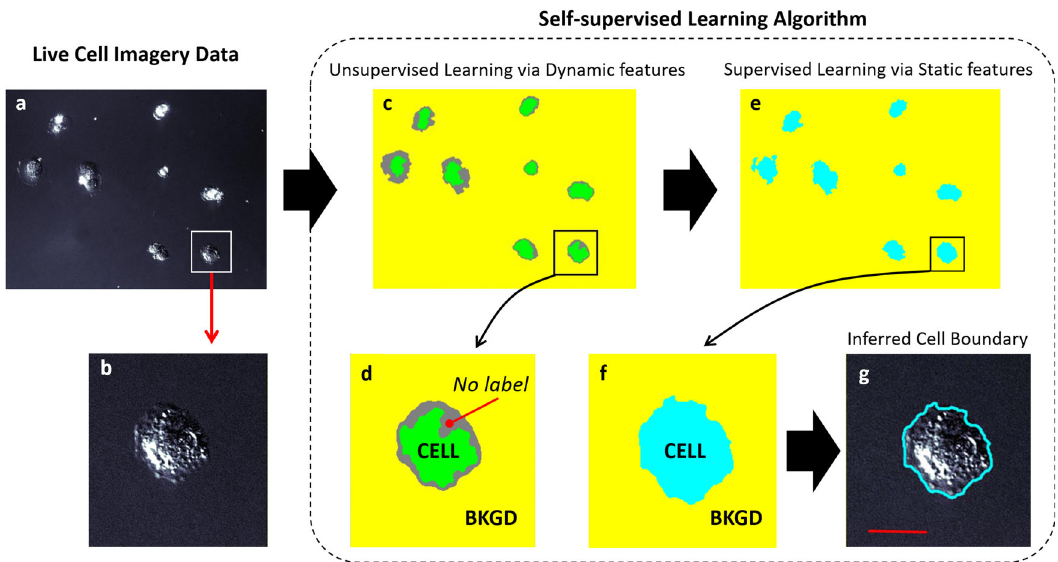
Fig. 2 Overview of the automated self-supervised learning algorithm. a The contrast enhanced DIC image of several and b a single highlighted MDA-MB- 231 cell illustrates the range of intensities inherent within the cells. (20X objective). c , d Unsupervised learning via FD: high threshold FD is used to select only those pixels exhibiting the highest displacement magnitudes and labels them as ‘ cell ’ (green pixels). Similarly, low threshold FD is used to identify pixels with a much wider range of displacement magnitudes than the high fl ow regime. The lowest displacement magnitude pixels are labeled ‘ background ’ (yellow pixels). Pixels that exhibit FD in between these regimes remain unlabeled (gray pixels). e , f Supervised learning via self-labeled training data. The self-labeled pixels (green and yellow) are then used to generate static feature vectors, which are in turn used to train the classi fi er model. g The blue outline is the resulting segmentation which outlines all pixels classi fi ed by the FD trained model as ‘ cell ’ and is also overlaid on the image in b . This process is repeated at every time step, thereby using the most recent imagery to update the training data. Scale bar: 25 µ m (20X objective, time increment: 300